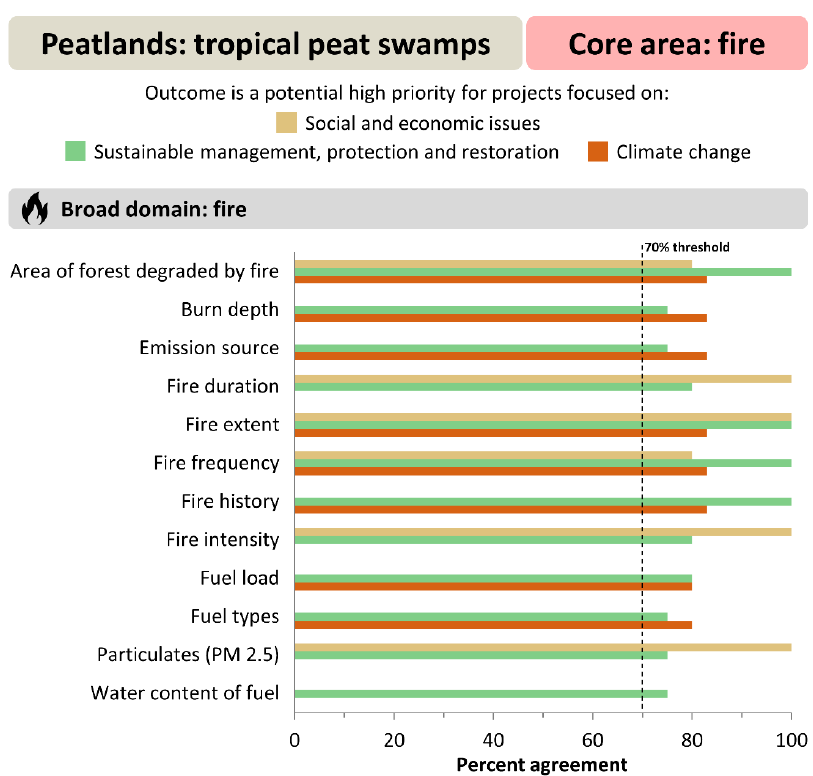
Figure 10. Fire core domain set, and the constituent target domain outcomes agreed by ≥ 70 % of respondents as potential high priorities for measurement in tropical peat swamp research or monitoring, depending on the objective or focus of the research or restoration project (based on six expert responses). Scores < 70 % are not